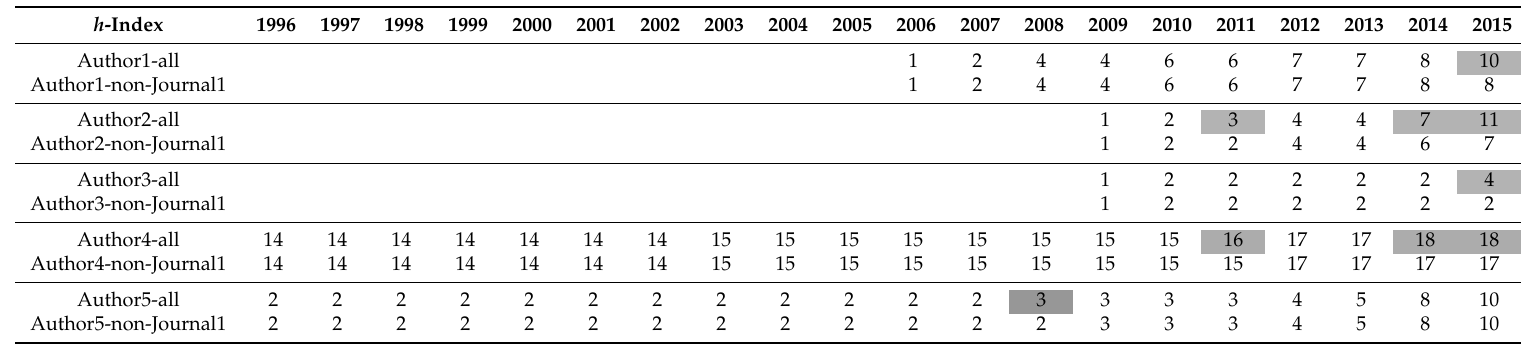
Table 3. Time dependence of the h -index for Author1, Author2, Author3, Author4, and Author5, distinguishing between citations of Author1, Author2,